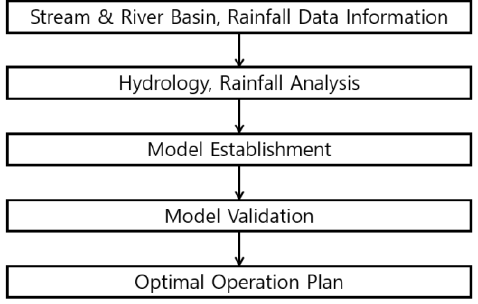
Figure 2. Research Flowchart.